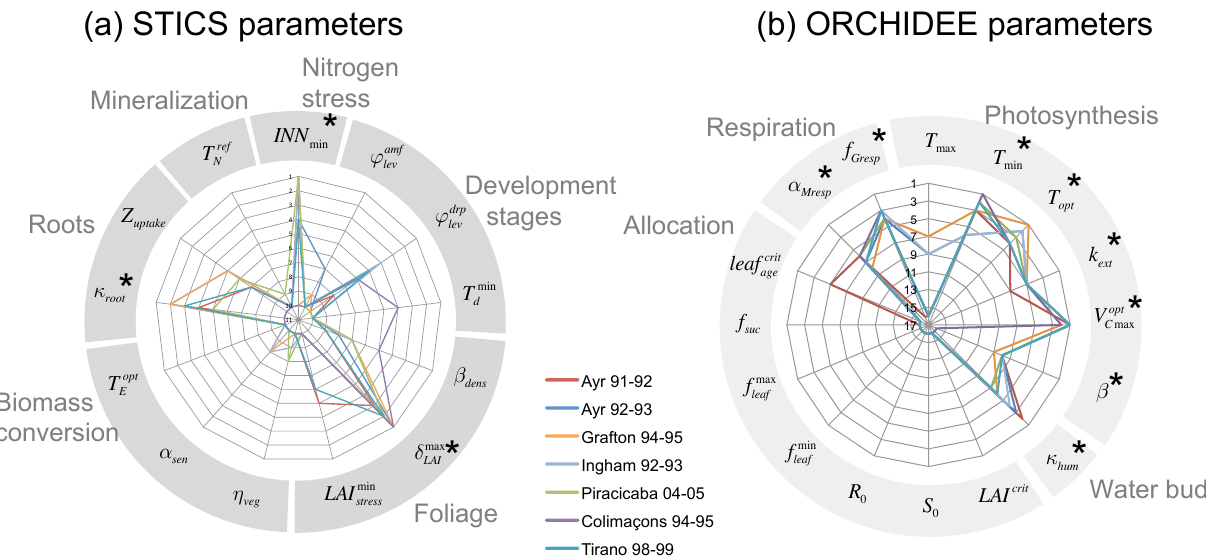
Figure 5. Parameters rankings derived from the Morris screening analysis for STICS parameters (a) and ORCHIDEE parameters (b) for seven sites (color lines). Each axis of the radar plot corresponds to the rank of a parameter, the lower the rank, the more important the